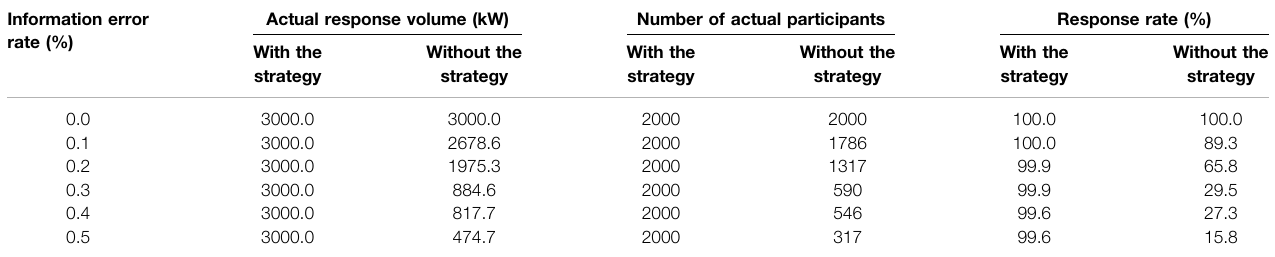
TABLE 4 | Implementation results of different information error rates in Case 1. Information error rate (%)